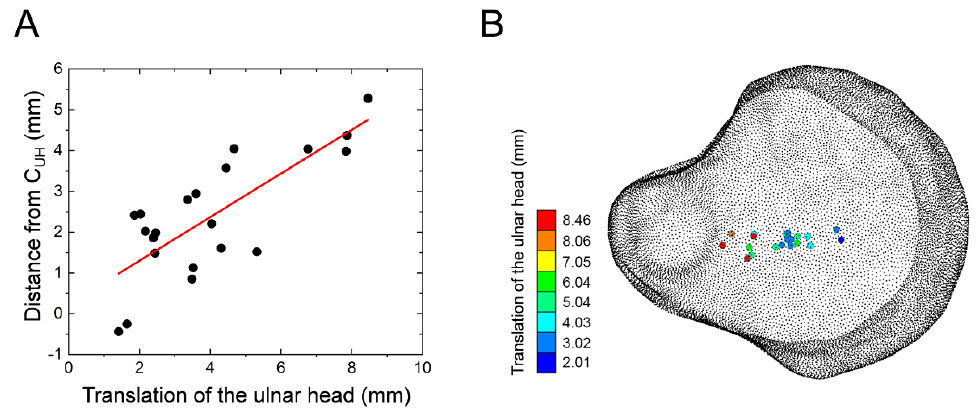
Figure 4 . The location of the RC in the radioulnar direction and the amount of translation of the ulnar head (TUH). ( A ) The location of the RC in the radioulnar direction was significantly correlated with the amount of TUH (Pearson’s correlation coefficient = 0.775, p < 0.001). ( B ) The color-gradient diagram shows that the RC was located more ulnarly when the TUH was greater.